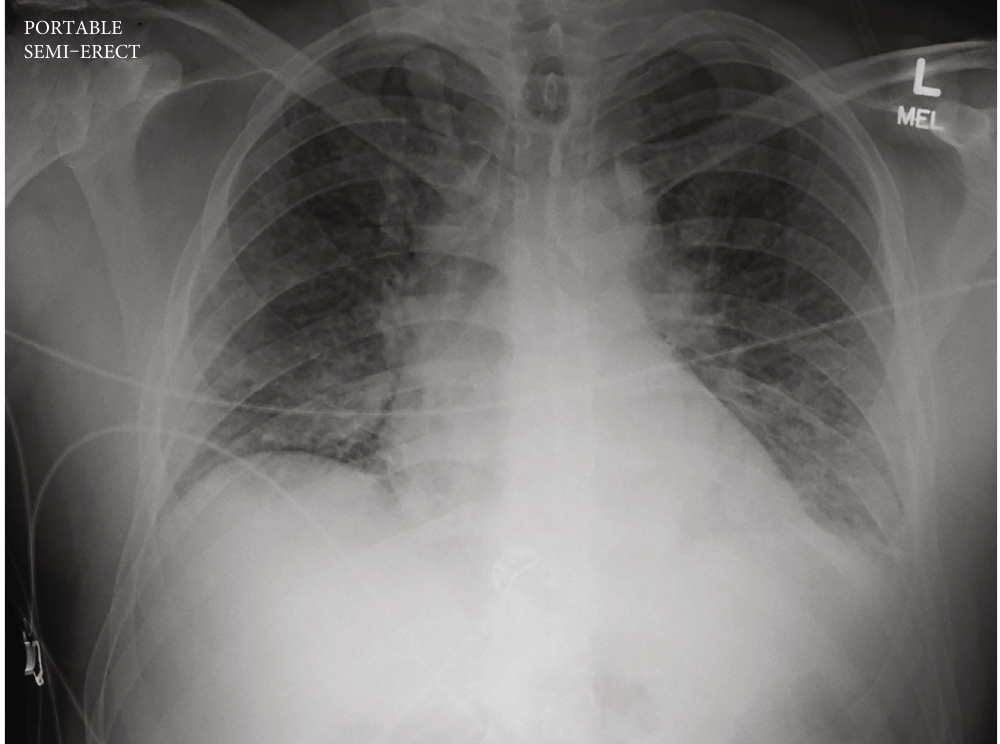
Figure 1: Chest X-ray on admission shows bilateral pulmonary in fi ltrates concerning for pulmonary edema vs.